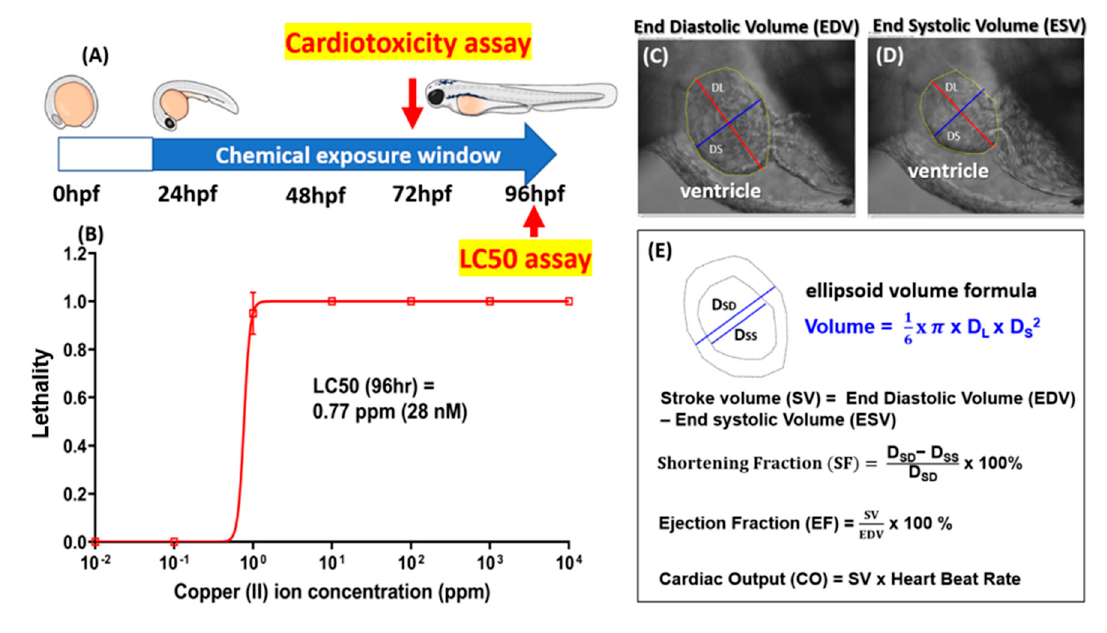
Figure 3. The experimental design, 96 h LC50, and mathematical formulae used to calculate cardiac performance in zebrafish. ( A , B ) Zebrafish embryos aged 24 h postfertilization (hpf) were treated with GHK tripeptide and copper combinations for 48 h continuously, and the cardiac-related endpoints, as well as mortality (LC50), were measured at 72 and 96 hpf, respectively. The LC50 values were predicted by a curve-fitting method. The outlooks of the ventricles were determined at either the diastolic ( C ) or systolic ( D ) phases. ( E ) The mathematical formulae used to measure the shortening fraction, ejection fraction, stroke volume, and cardiac output in the ventricle were investigated for zebrafish embryos aged 72